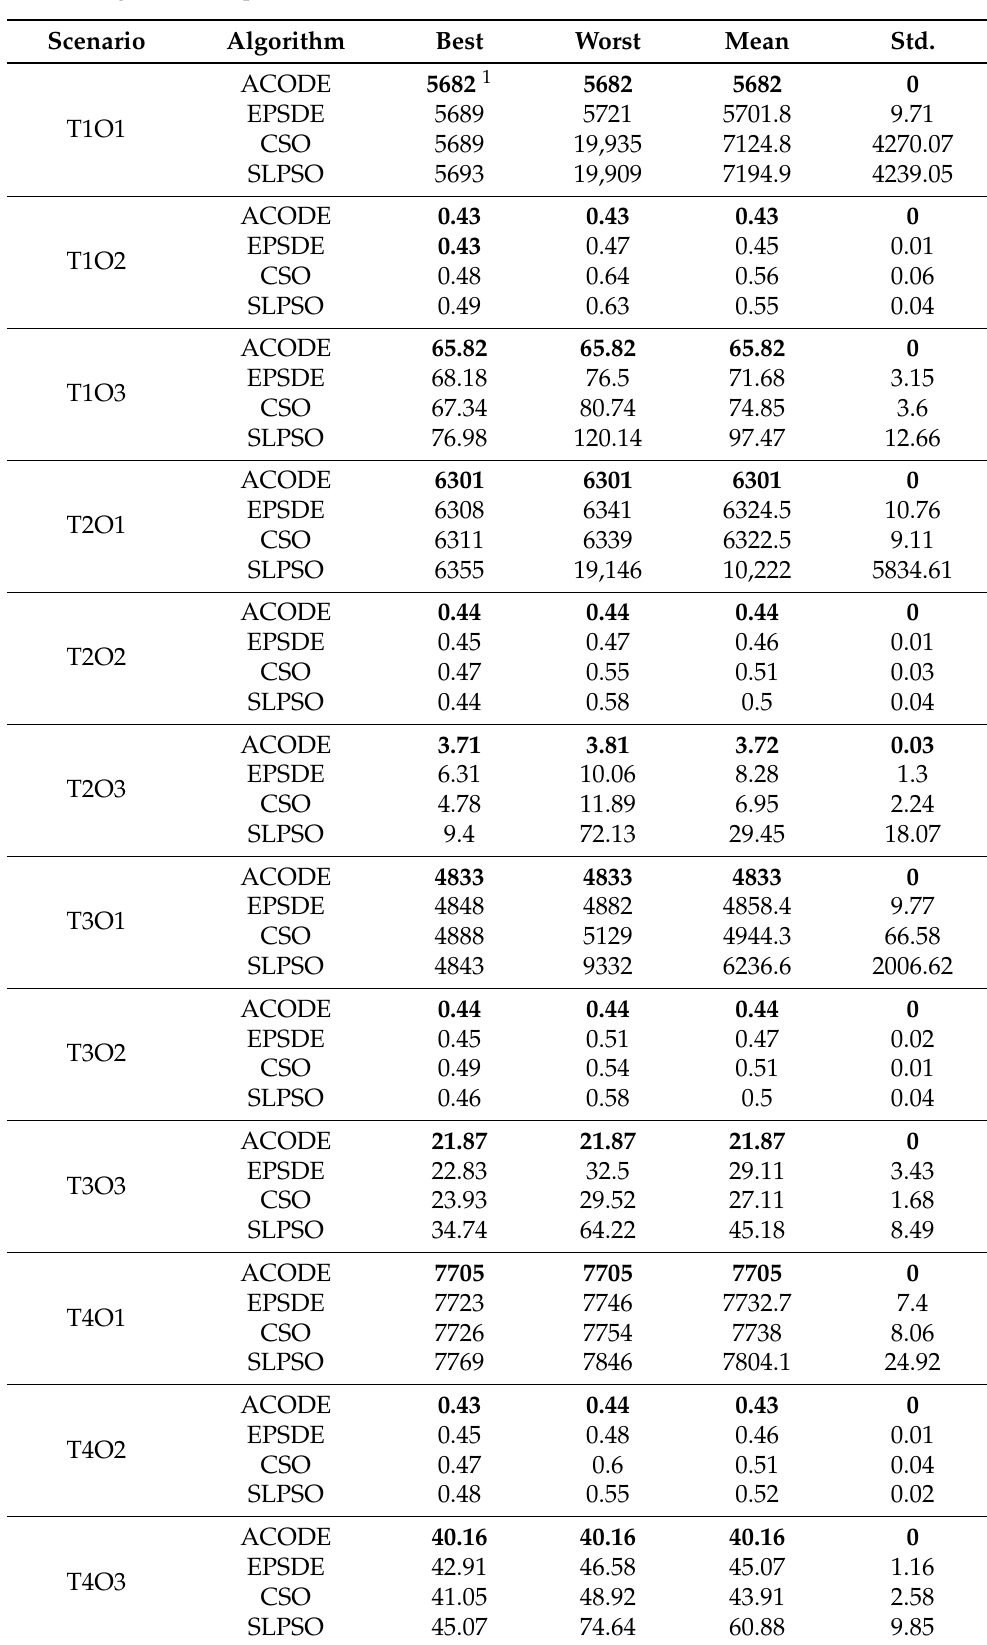
Table 6. Algorithm comparison